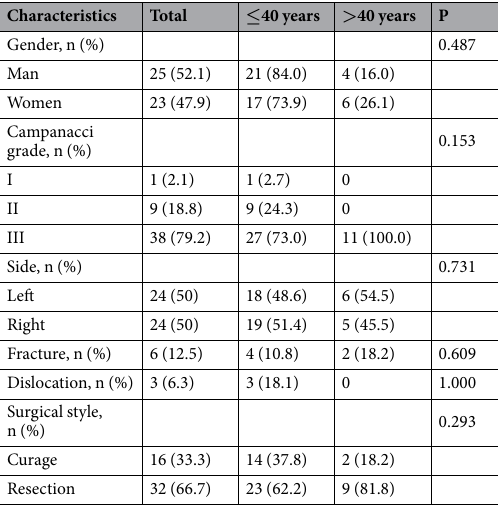
Table 3. Clinical characteristics of primary GCT of the distal radius by age